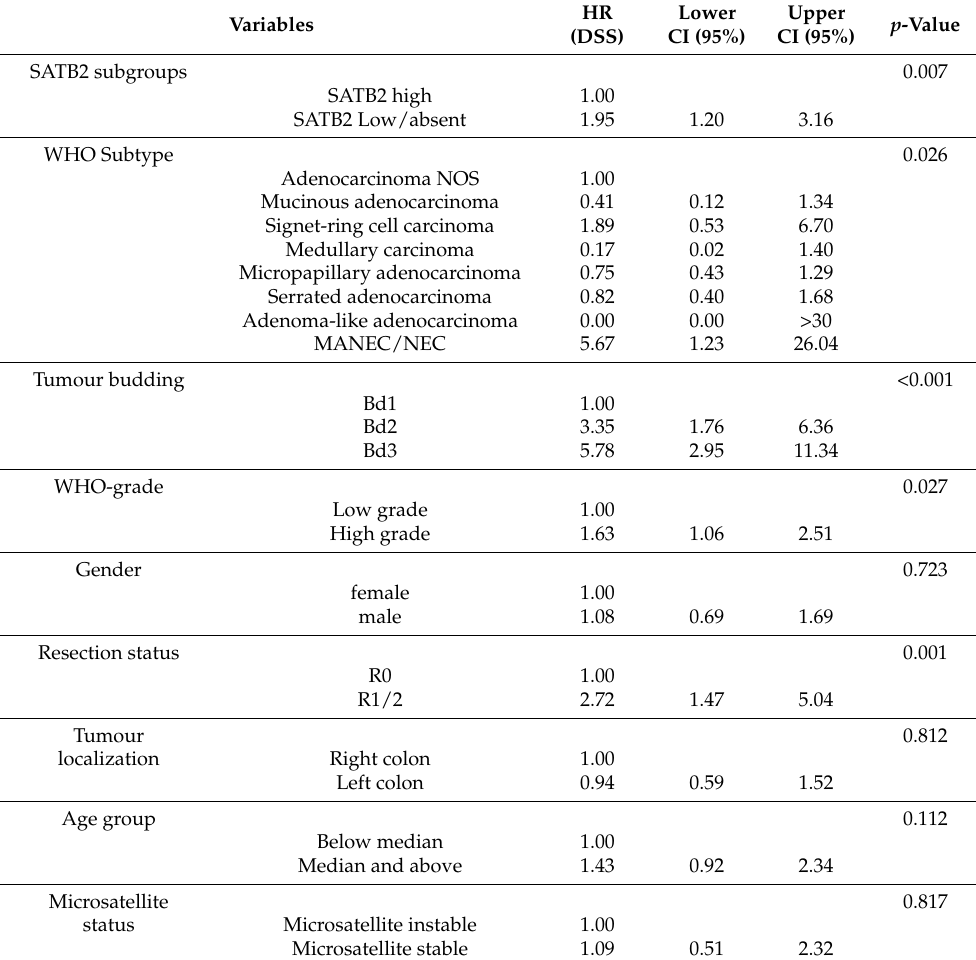
Table 3. Multivariate disease-specific survival analysis in the UICC stage III subcohort under inclusion of SATB2 expression, age, gender, CRC subtype, tumour budding, WHO grade, resection status and microsatellite status.